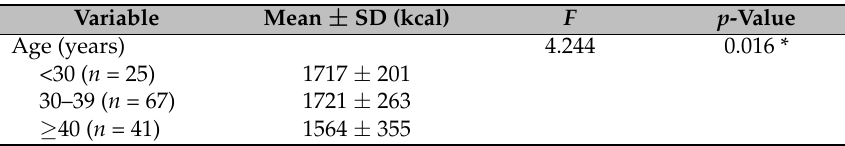
Table 6. Difference between age and energy intake among respondents ( n = 133).